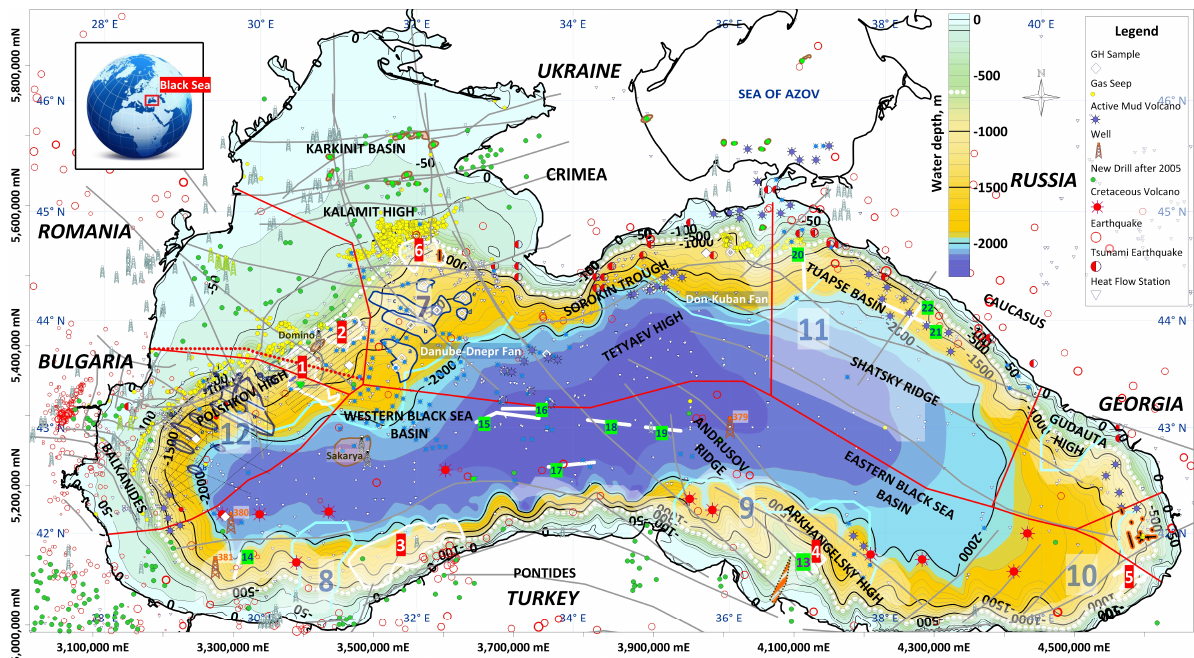
Figure 2. Black Sea bathymetry [23]. Data and objects from Figure 1.